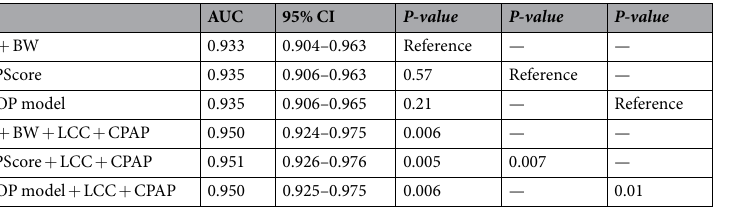
Table 4. AUCs for prediction of TR-ROP from all infants using combination of ROPScore, CHOP model and significant predictors. Abbreviations: AUC, area under receiver operating characteristic curve; ROP, retinopathy of prematurity; TR-ROP, treatment-requiring retinopathy of prematurity; CI, confidence interval; GA, gestational age; BW, birthweight; CHOP model, Children’s Hospital of Philadelphia model; LCC, late-onset circulatory collapse; CPAP, continuous positive airway